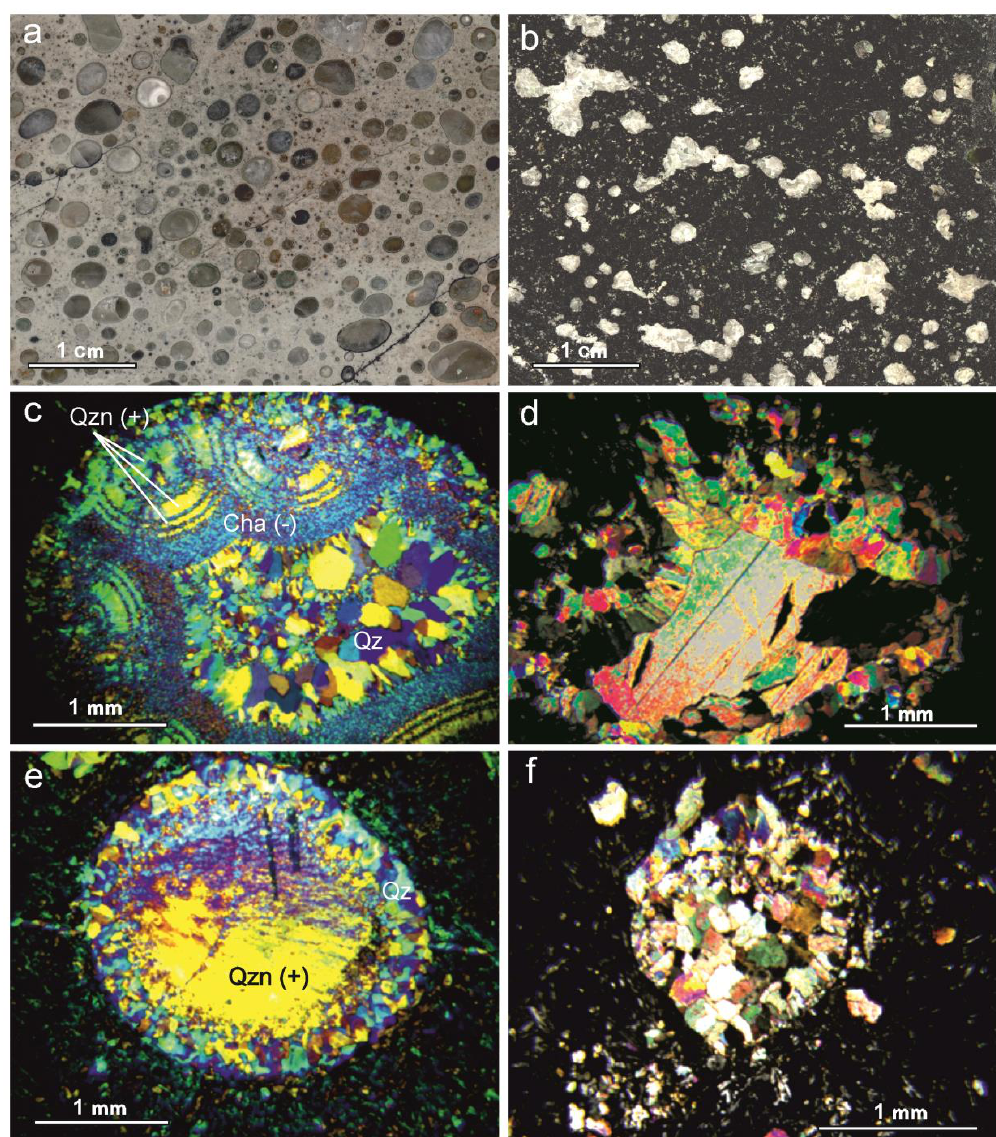
Figure 6. Vesicular basalts (mandelstones) from the LSH of the Onega Basin: Pinguba occurrence (left column, a , c , e ), Yalguba Ridge occurrence (right column b , d , f ). Polarized light micrographs (crossed nicols, compensator plate) of concentrically zonal amygdales ( c , e ) filled by fine-flaked and fibrous chalcedonyCha(-), fibrousquartzineQzn( + ), andinequigranularquartz(Qz).Transmittedlightmicrographs (crossed nicols) of calcite amygdales ( d , f ) filled by fine-grained, fan-shaped, and crystalline